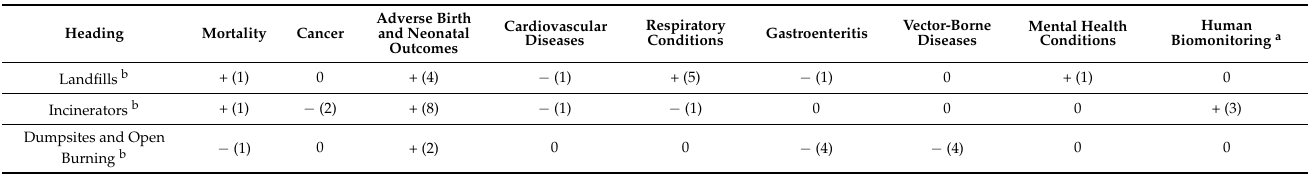
Table 7. Evidence to develop health outcomes among residents living nearby landfills, incinerators, and dump- sites/open